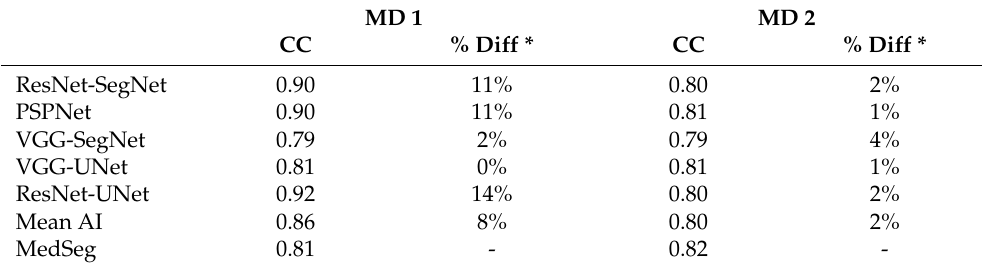
Table 2. Correlation coefficient plot: 5 AI models vs. MD 1 and 5 AI models vs. MD 2.